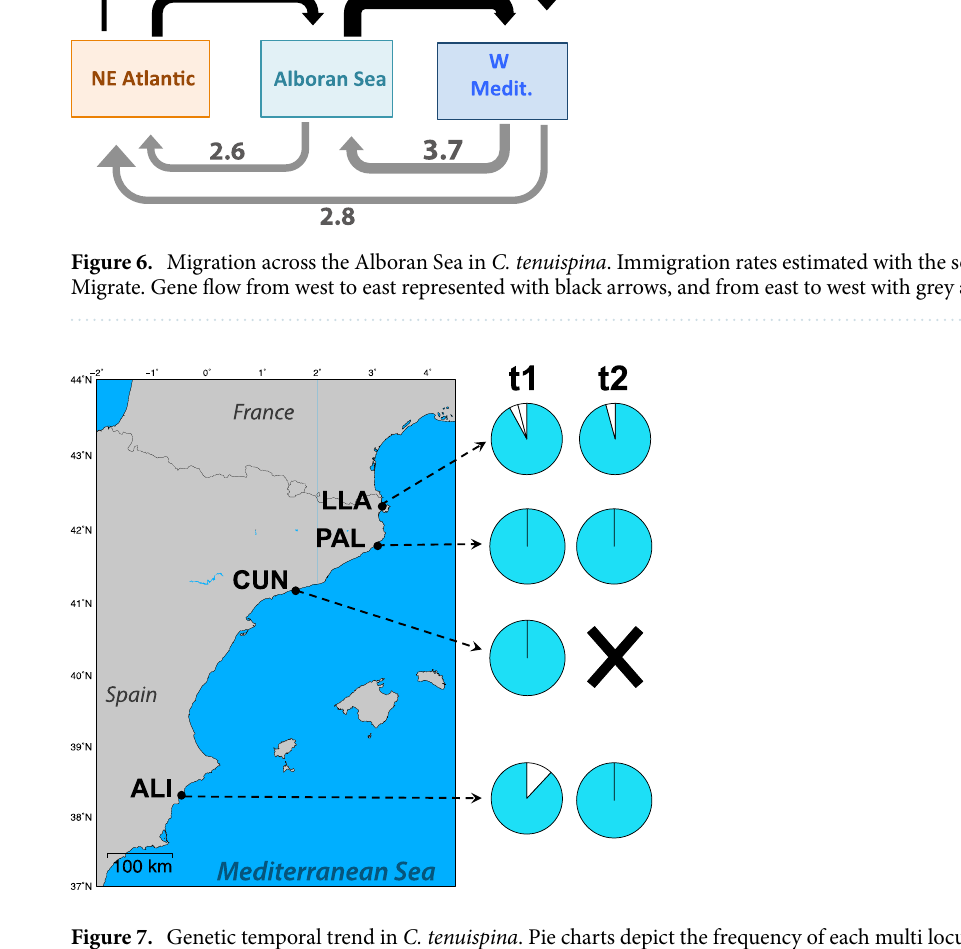
Figure 7. Genetic temporal trend in C. tenuispina . Pie charts depict the frequency of each multi locus genotype (MLG) per site at t1 and t2. White partitions represent private MLGs, and blue colour shared genetic variants among localities and over time. For CUN no individuals were found at t2. This map was created with the free software MAPTOOL: SEATURTLE.ORG Maptool. 2002. SEATURTLE.ORG, Inc. http:// www. seatu rtle. org/ mapto ol/ 23 July